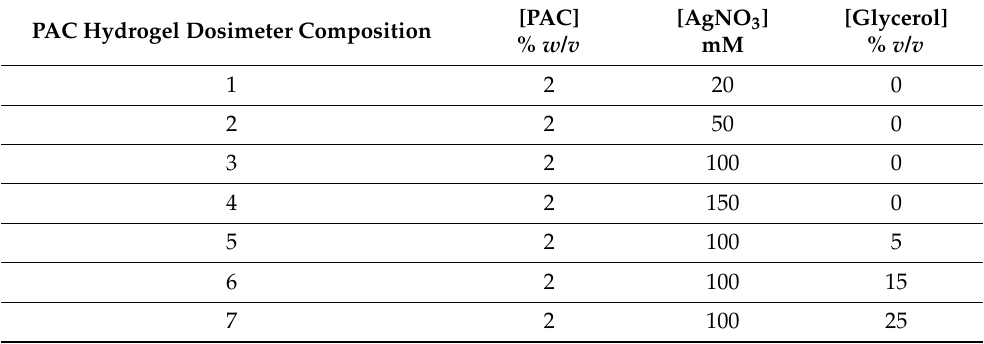
Table 6. Different compositions of PAC hydrogel